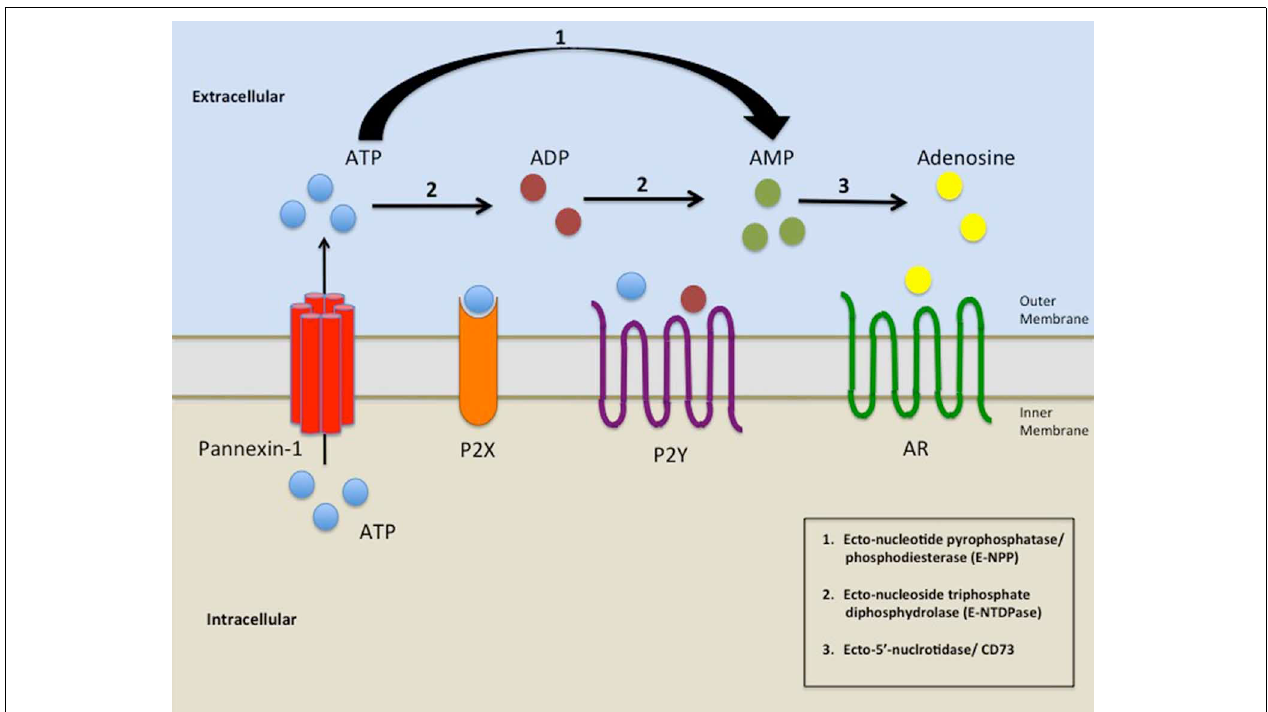
FIGURE 1 | A schematic representation of the elements involved in the release of ATP by opening of Panx-1 hemichannels and subsequent activation of purinergic signaling. Pathological or physiological stimuli result in the opening of Panx-1 hemichannels promoting the release of ATP from the cell. ATP/ADP/AMP could then bind to P2X and P2Y receptors. Ecto-nucleoside triphosphate